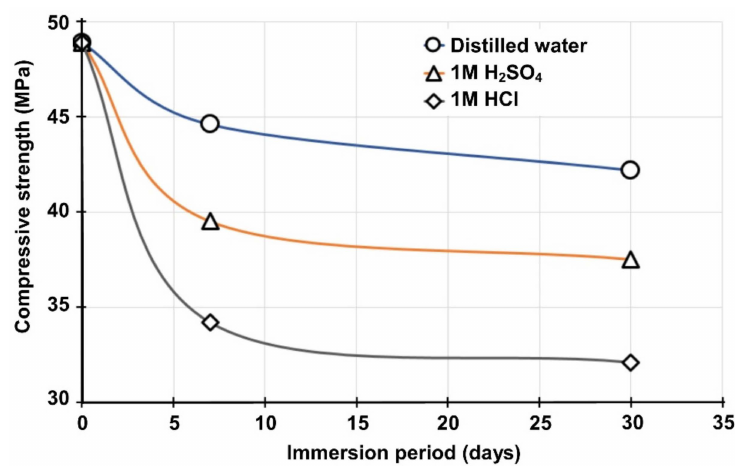
Figure 9. Compressive strength of B50S50 IPs after immersion in distilled water and acidic solutions for 7 and 30